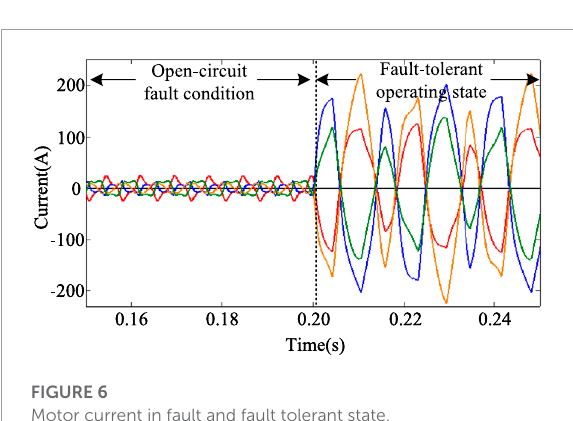
FIGURE 3 Flow chart of chaotic particle swarm optimization α . TABLE 1 Parameters of five-phase permanent magnet synchronous motor.